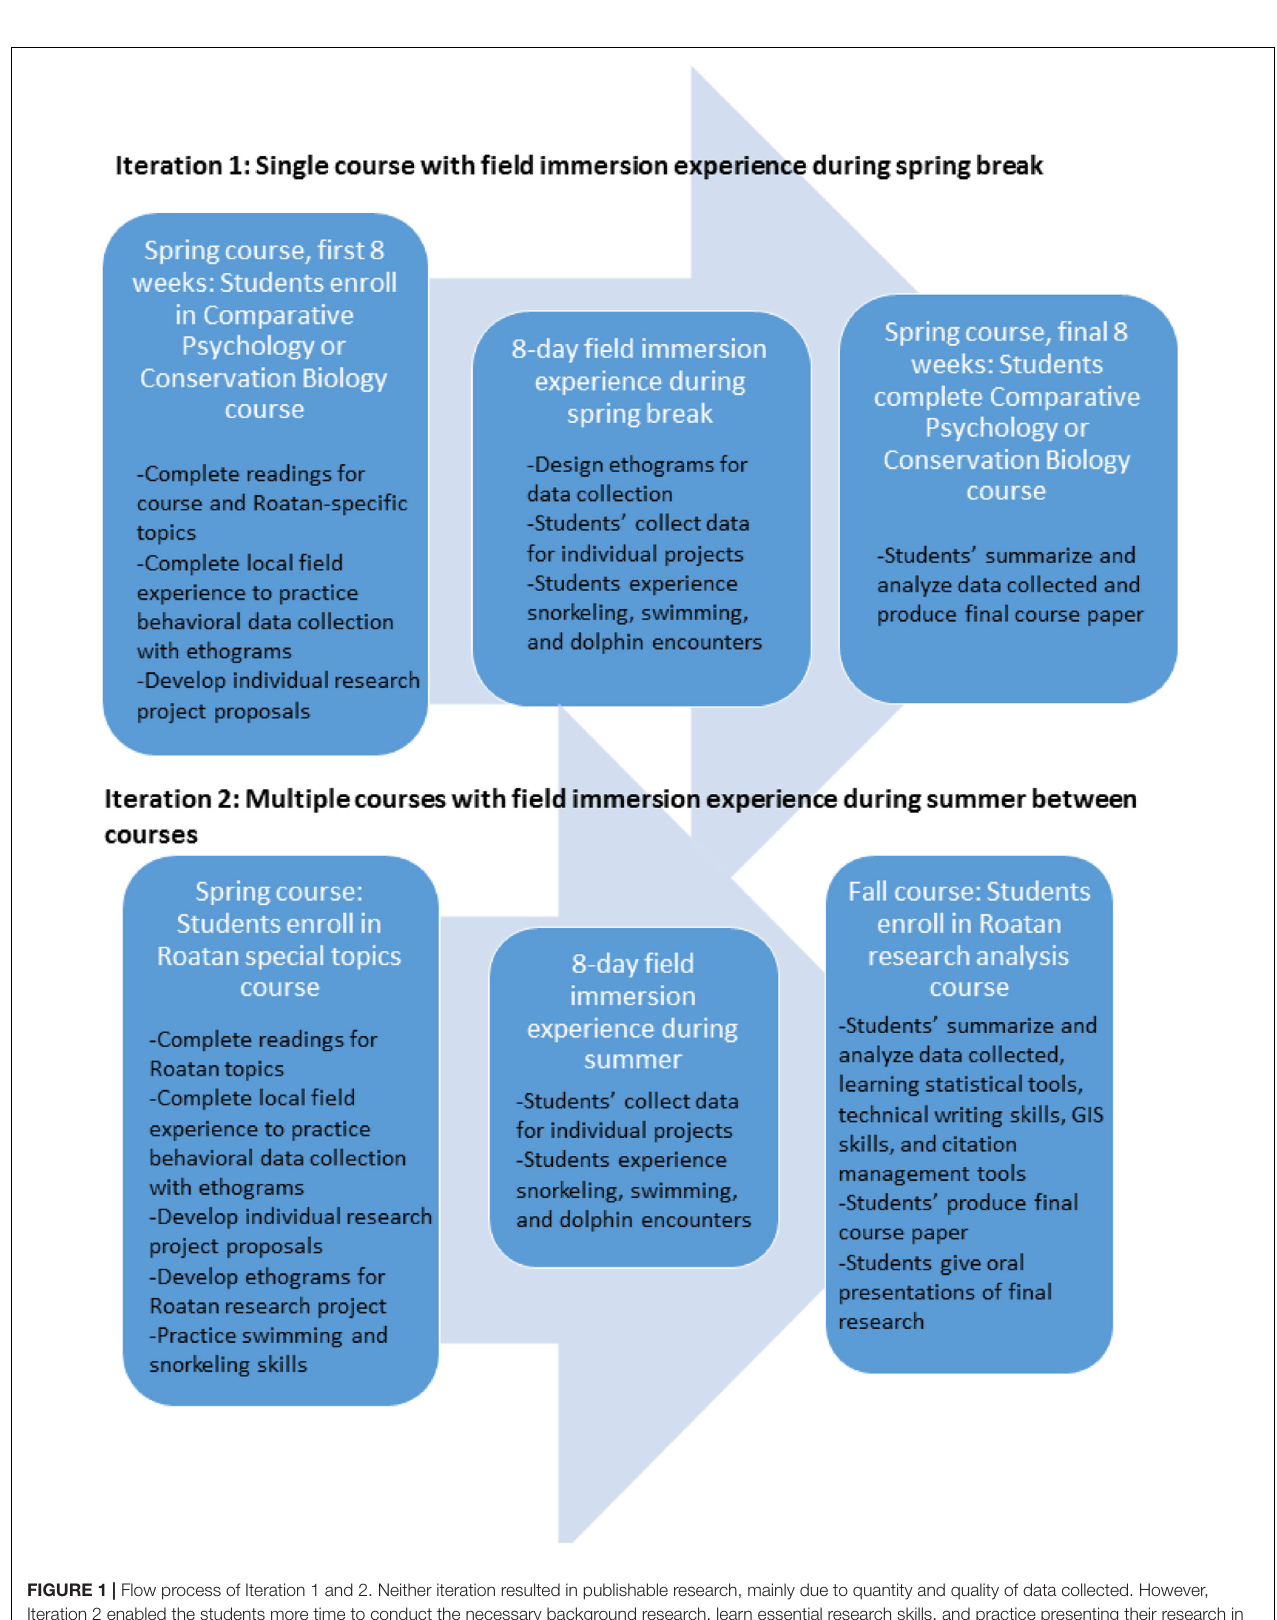
FIGURE 1 | Flow process of Iteration 1 and 2. Neither iteration resulted in publishable research, mainly due to quantity and quality of data collected. However, Iteration 2 enabled the students more time to conduct the necessary background research, learn essential research skills, and practice presenting their research in an oral format. Based on feedback from the students’ in each iteration, and the progress made in research skills and results in Iteration 2, we recommend future experiences incorporate longer field immersion experiences.